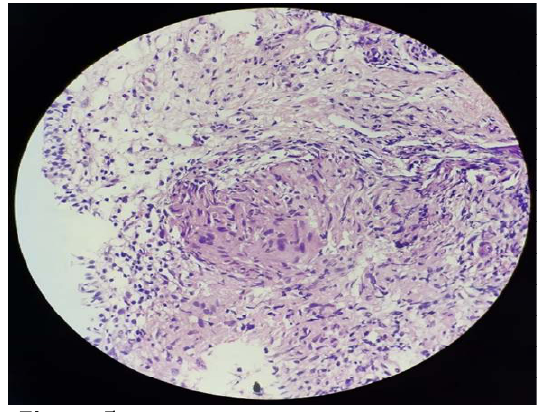
Figure 4: Bronchoscopy image: Endobronchial nodules in right middle lobe